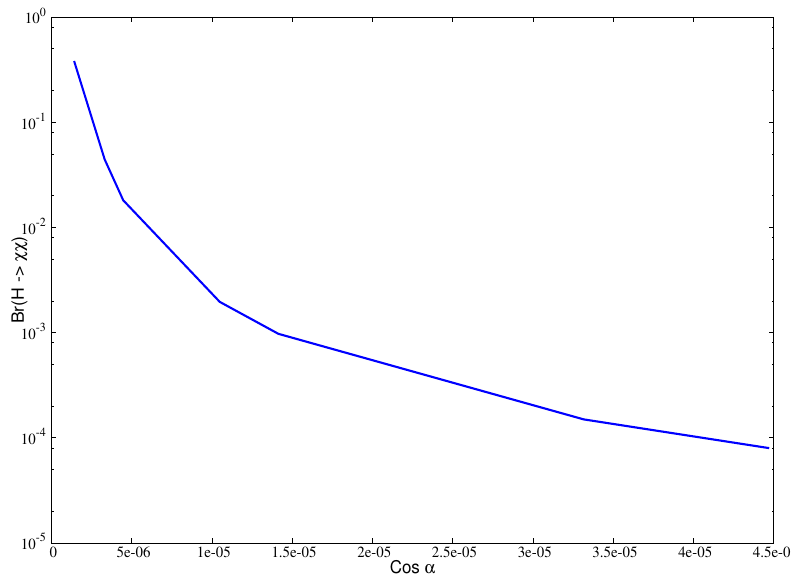
Figure 6 . Br( H ! (cid:31)(cid:31) ) as a function of the mixing